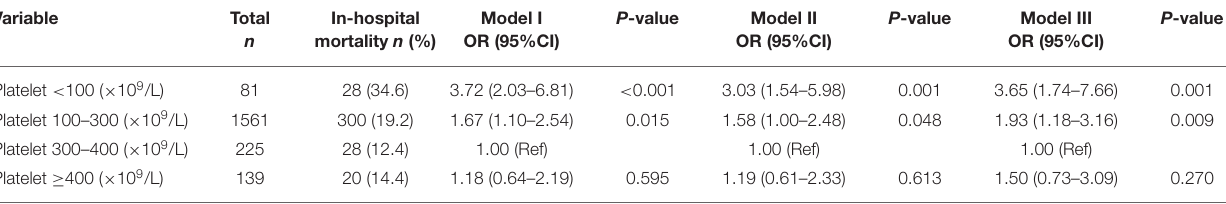
TABLE 1 | Multivariable logistic regression models evaluating the association between platelet count and in-hospital mortality. Variable